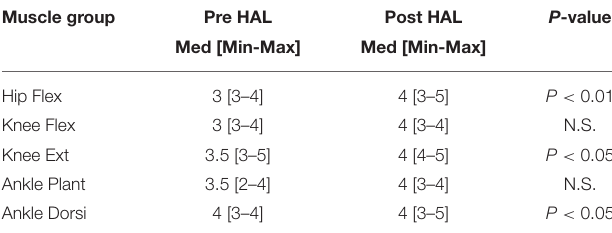
( Table 4 ). ROM of hip joint: 36.1 ◦ vs. 40.3 ◦ ( P < 0.01) has increased and slightly changed to flexion position ( Figure 2A ). Knee joints ROM was non-significant, and the double knee action has appeared in the initial stance stage: 4.8 ◦ vs. 7.2 ◦ ( P < 0.05) ( Figure 2B ). Ankle joints ROM was 25.5 ◦ vs. 26.7 ◦ (N.S.) ( Figure 2C ), and it changed to plantar flexion position. This change could have been caused by the displacement of the ROM of hip joint that moved to flexion position. Improvement in toe lift: 109.7 vs. 128.0mm ( P < 0.01) was observed ( Figure 2D ). Pelvic angle has changed to an anterior tilt angle of 100.4 ◦ vs. ( P < 0.05) ( Figure 2E ). MMT scores of the chronic patients TABLE 3 | Comparison of MMT scores between pre and post HAL intervention in acute stage patients. Muscle group